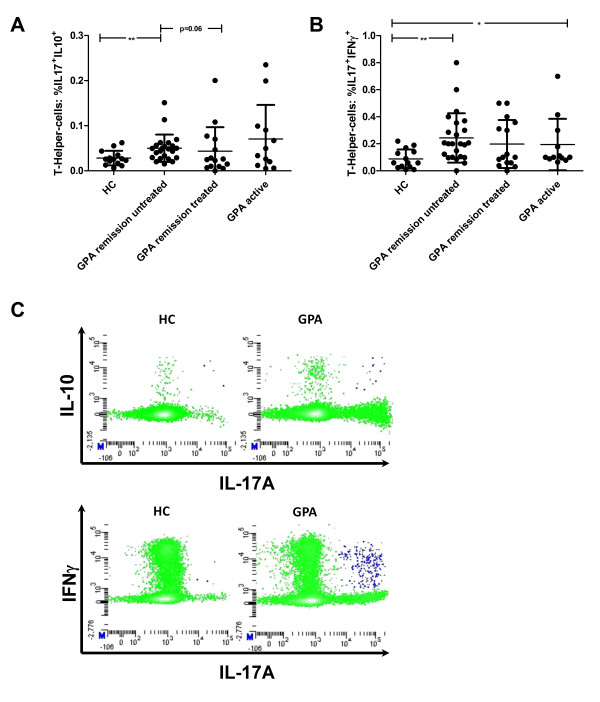
Th17 cell subsets are increased in granulomatosis with polyangiitis (GPA). (A) IL-17+IL-10+ CD4+ T cells were increased in quiescent, untreated GPA compared to quiescent, treated GPA and healthy controls (HC). No difference was detected between HC and patients with active GPA. (B) IFNγ producing Th17 cells were increased in quiescent, untreated GPA and active GPA compared to HC. Means are indicated by the horizontal line, and the error bars represent the SD. (C) Representative fluorescence-activated cell sorter (FACS) plots of a HC and a GPA patient. IL-10 and IFNγ producing Th17 cells are depicted in the upper right corner (blue). Plots are gated on CD3+CD8neg T cells, 30,000 events were acquired for each sample in this gate. *P < 0.05, **P < 0.008.